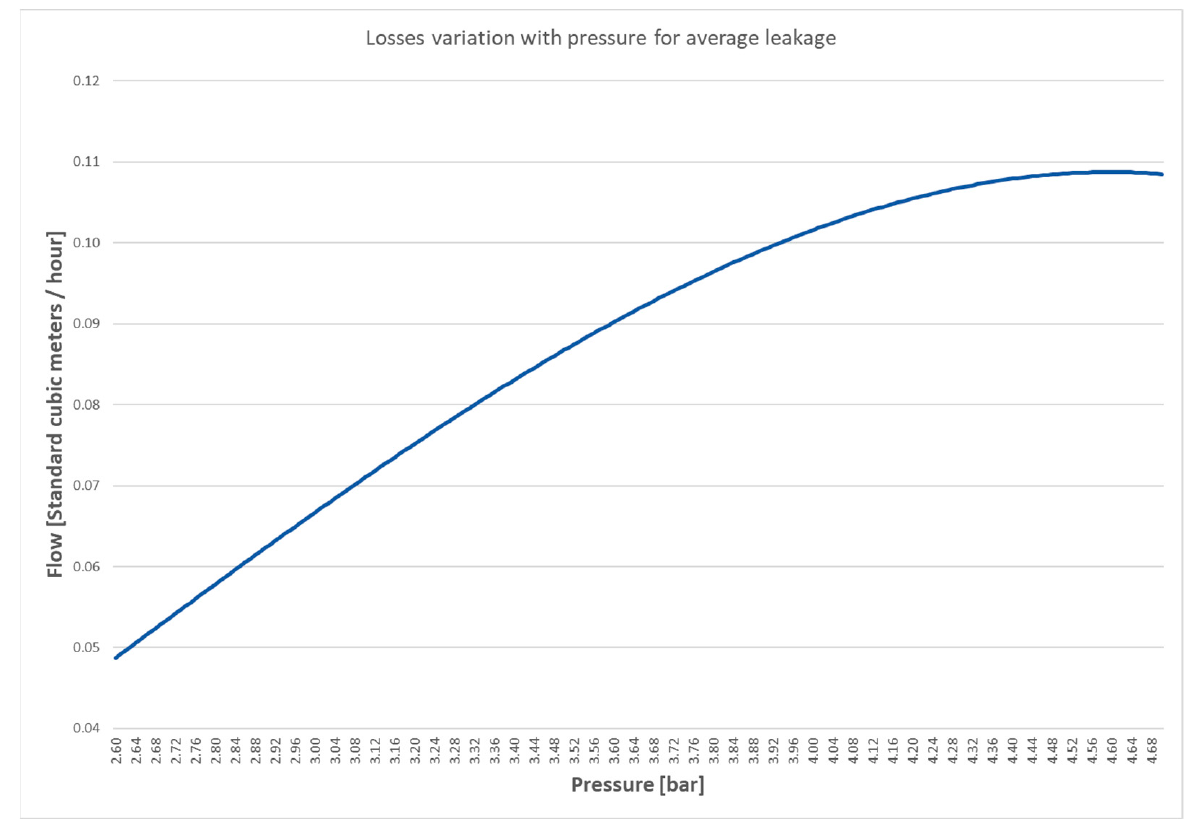
Figure 10. Variation in lost gas flow rate as a function of average pressure for average faulty fitting (source: authors based on the analysed data).